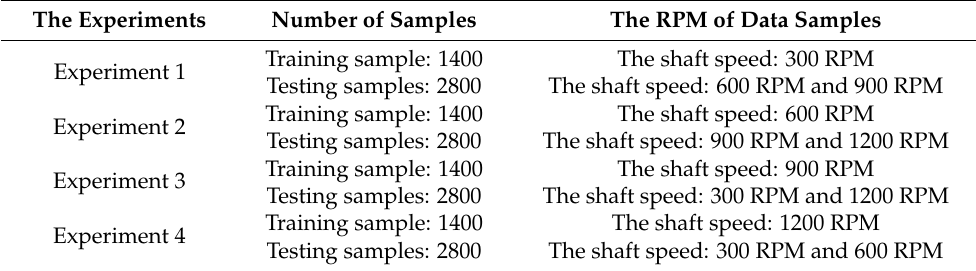
Table 2. Description of the dataset for training and testing with RPM in the experiment